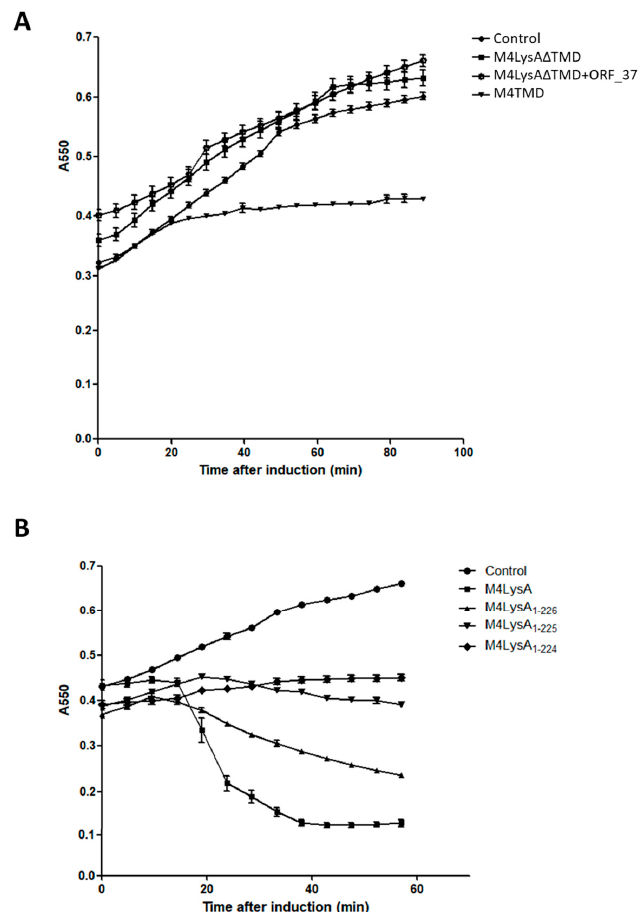
Figure 5. Functional analysis of the M4Lys transmembrane domain. ( A ) Catalytic domain (M4Lys Δ TMD), C-terminal TMD of M4Lys (M4TMD), and a putative lysis protein B (ORF_37) were produced separately or together in E. coli BL21 (DE3) cells. Closed circles, empty vector; closed square, expression of M4Lys Δ TMD; open square, coexpression of M4Lys Δ TMD and ORF_37; and reverse closed triangles, expression of TMD; ( B ) Lysis activity of various deletion mutants compared with the full-length M4Lys. Closed circles, empty vector; closed squares, full-length M4Lys; closed triangles, 11 amino acid deletion in TMD of M4Lys (M4Lys 1–226 ); reverse closed triangles, 12 amino acid deletion in M4Lys TMD (M4Lys 1–225 ); and closed diamonds, 13 amino acid deletion of M4Lys TMD (M4Lys 1–224 ). Truncation of 13 amino acids from the M4Lys sequence eliminated the lytic activity. All protein expression was induced by adding 0.1 mM IPTG. Experiments for cell lysis kinetics were performed in triplicate and the results of each treatment are represented by the mean ± standard deviation.